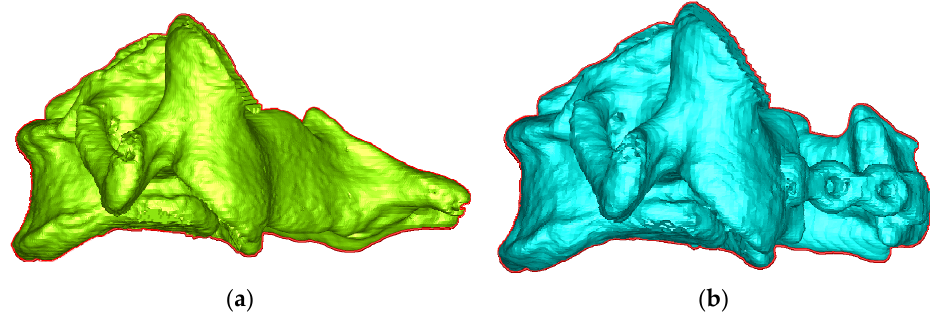
Figure 4. Lateral view and contour of vertebra in ( a ) pre-OP and ( b ) post-OP. The data structure of the two contours was built as a K-D tree [29]. The matching pair was found by searching the nearest point of contour B to a point on contour A through the K-D tree structure: